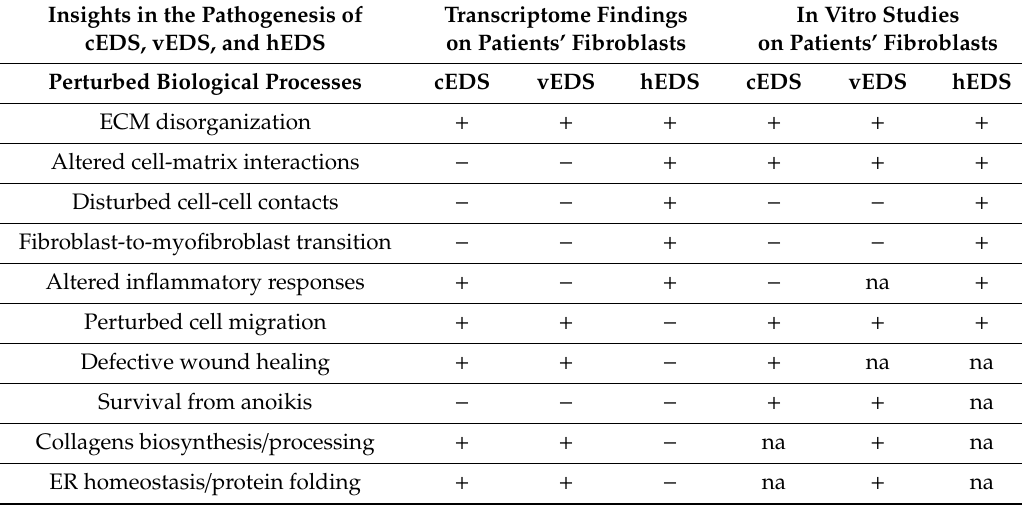
Table 2. Overview of the biological processes dysregulated in cEDS, vEDS, and hEDS patients’ dermal fibroblasts emerged from transcriptome and in vitro